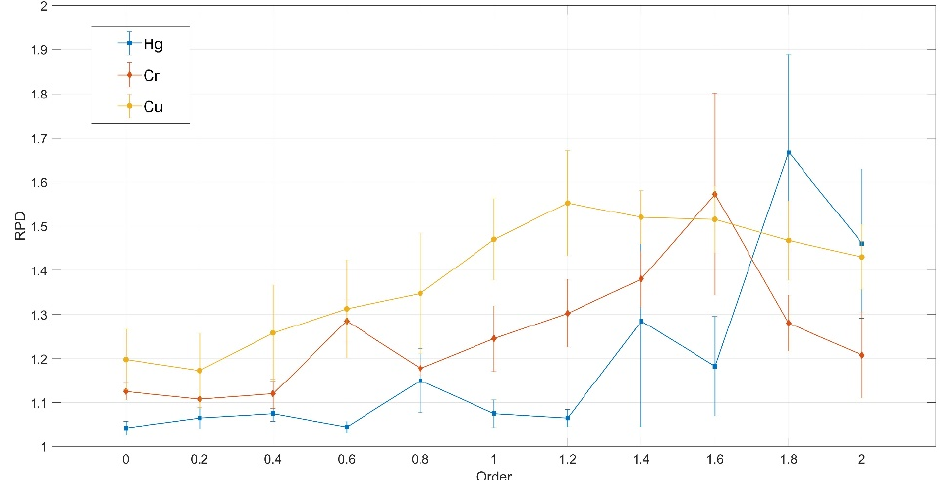
Figure 4. Error bar of RPD versus concentration estimation of Hg, Cr and Cu using fractional-order derivatives.